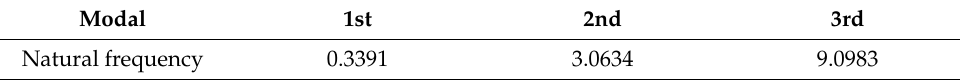
Table 2. First three orders of inherent frequency of towers under a rigid foundation (unit: Hz). Modal 1st 2nd 3rd Natural frequency 0.3391 3.0634 9.0983 2.4. Solving the Nacelle Attitude Angle Using Euler Angles